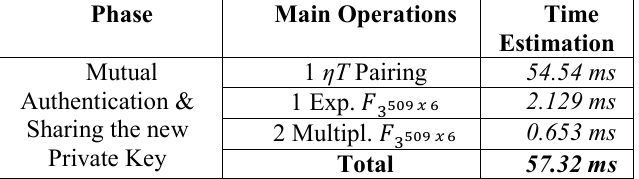
Table V. Estimation of RFID-Tate at 104